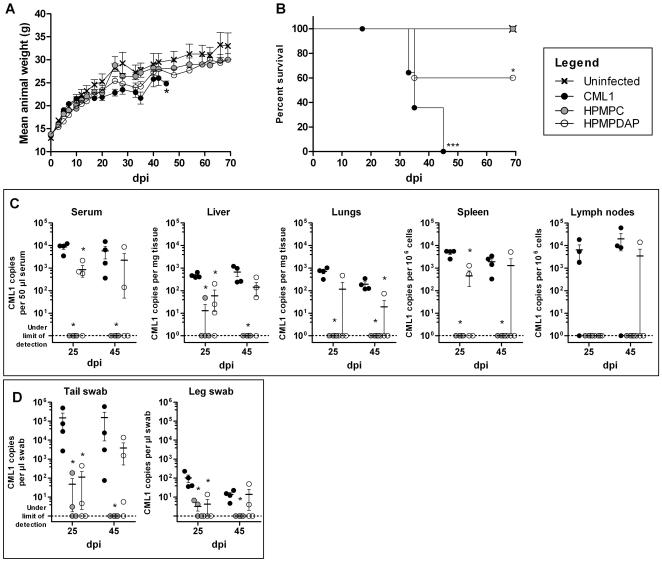
HPMPC protects against lethal CML1 i.n. challenge, whereas HPMPDAP showed an intermediate protection.
Nu/nu mice were inoculated i.n. with PBS (uninfected group) or with CML1 at a dose of 2.0×106 PFU (CML1, HPMPC and HPMPDAP groups). HPMPC and HPMPDAP groups were treated intraperitoneally for 3 days, starting the day of infection, with 50 mg/kg of HPMPC or HPMPDAP, respectively; uninfected and CML1 groups received a similar treatment regimen but with PBS. Animals were monitored for 70 days for body weight (A). Survival curves (B) were built based on i.n. infected animals treated or not that were euthanized due to (i) failure in gaining weight and (ii) severe illness in comparison with uninfected controls (see materials and methods). Viral loads in the serum and various organs (C) and in skin swabs of tail and leg (D) were determined by qPCR at days 25 and 45 post-infection. Data are mean±SEM. Statistical analyses were performed as described in materials and methods. Results are representative of two independent experiments.